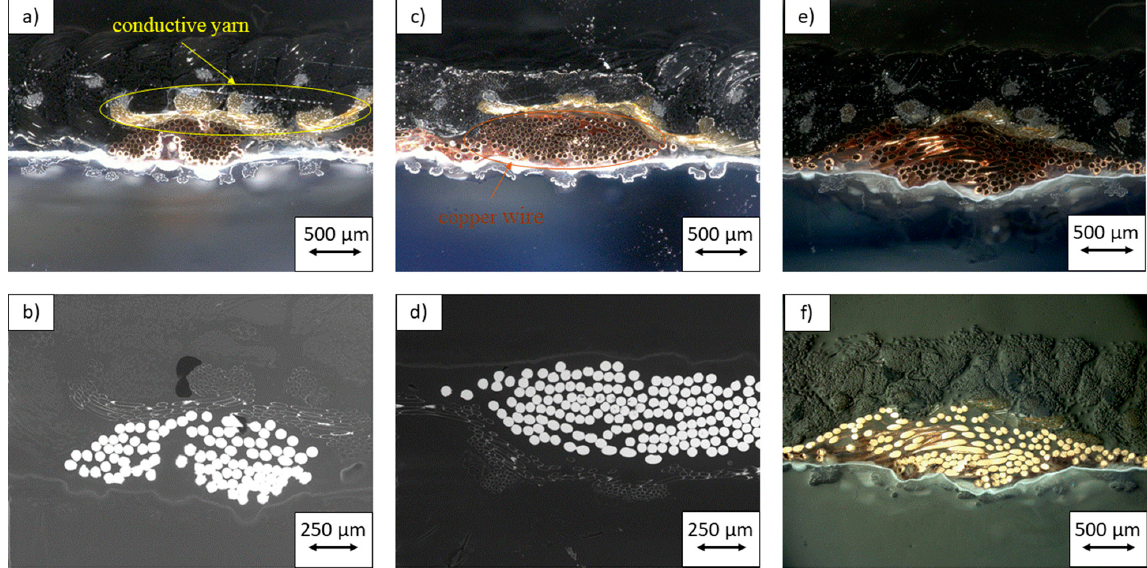
Figure 7. Microsections unwashed ( a , b ); 15 × washed ( c , d ); 30 × washed ( e , f ). Incident light microscope (upper row: a , c , e ) and scanning electron microscope (SEM) (bottom row: b , d , f ).